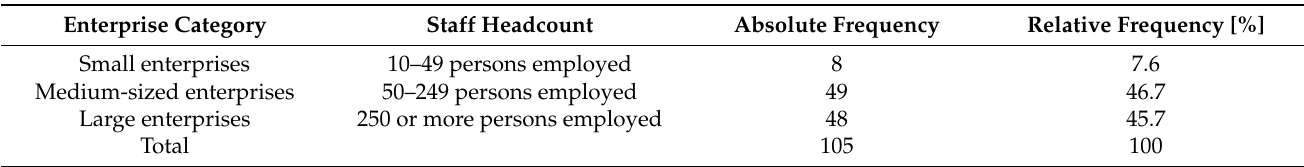
Table 1. Structure of studied sample by enterprise